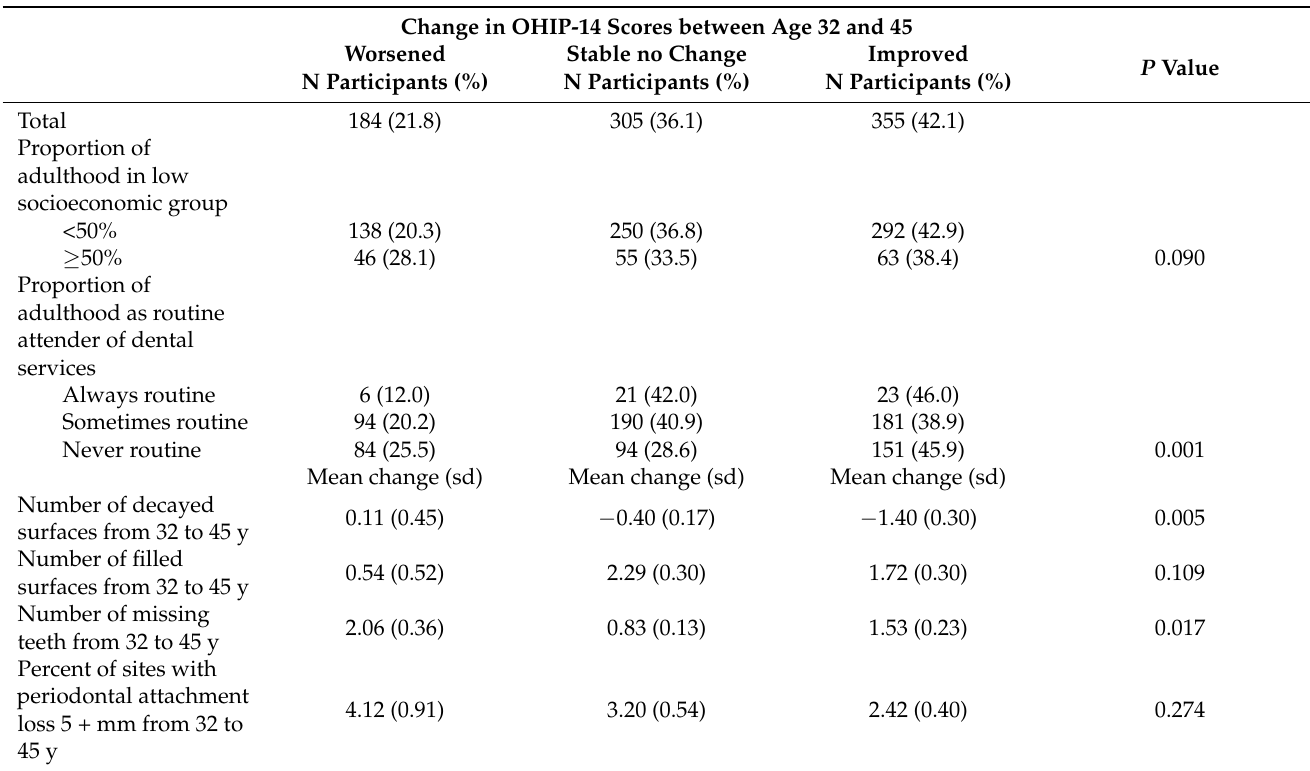
Table 2. Change in oral health impact profile (OHIP-14) score by socio-demographic characteristics and experience of oral